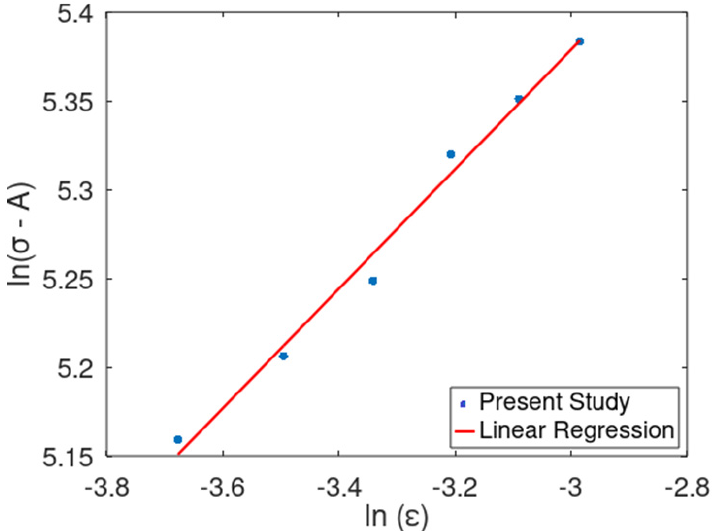
Figure 1. Curve fitting of true plastic stress-strain values to obtain B and n.